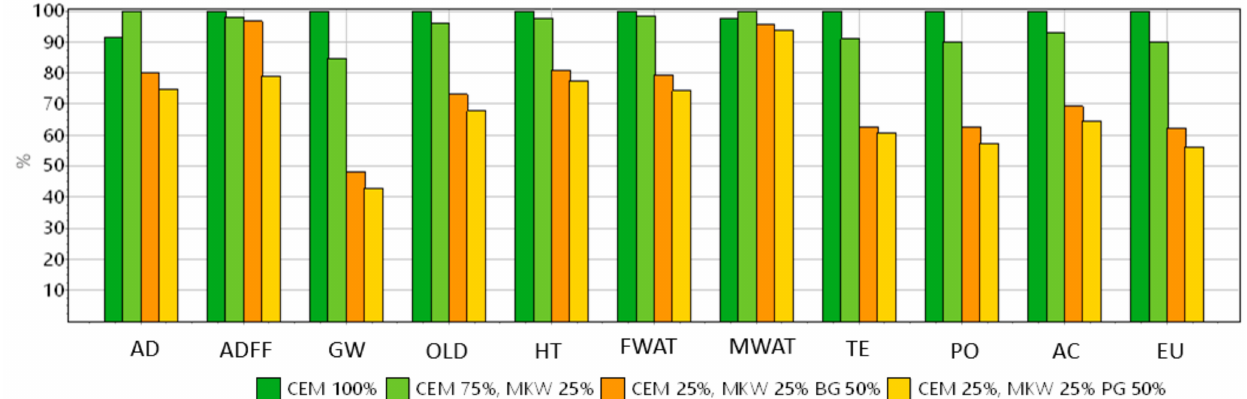
Figure 5. Comparison of different mortar mixtures regarding to the relative impact to the